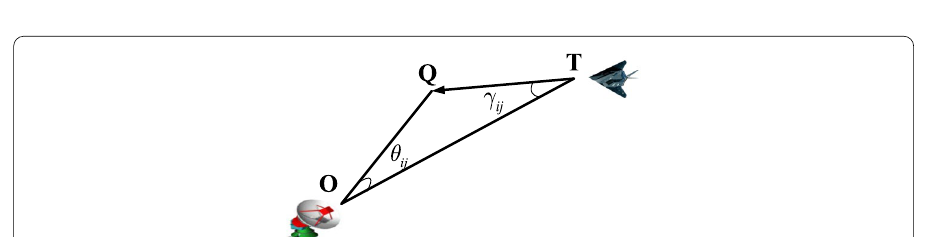
Fig. 4 The geometry relationship of ISAR